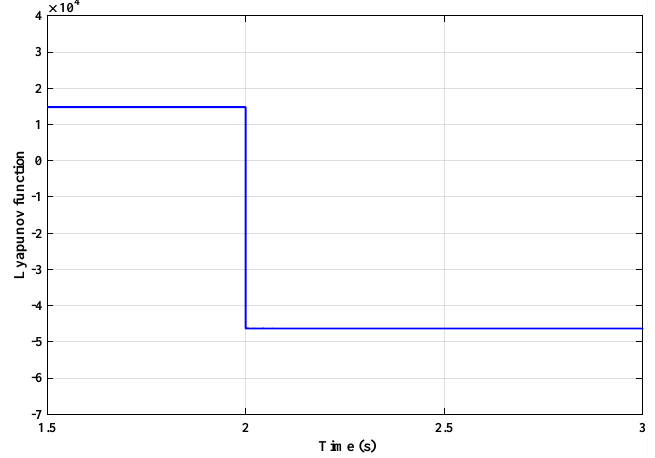
Figure 10. The energy function of the system with I d.ref = 50 A and change in K P from 70 to 140 at t = 2